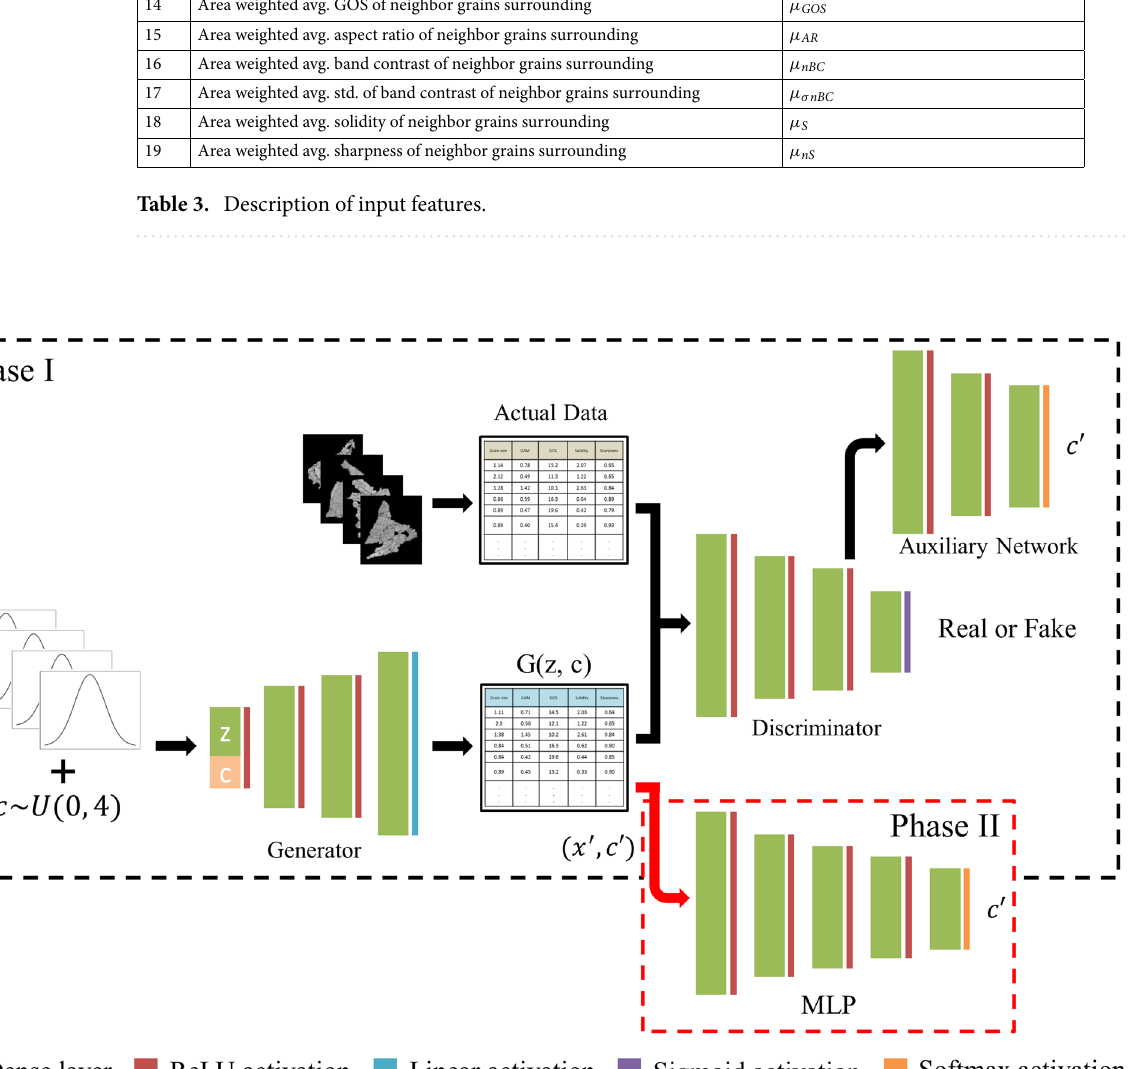
′ , c ′ ) that are given as input